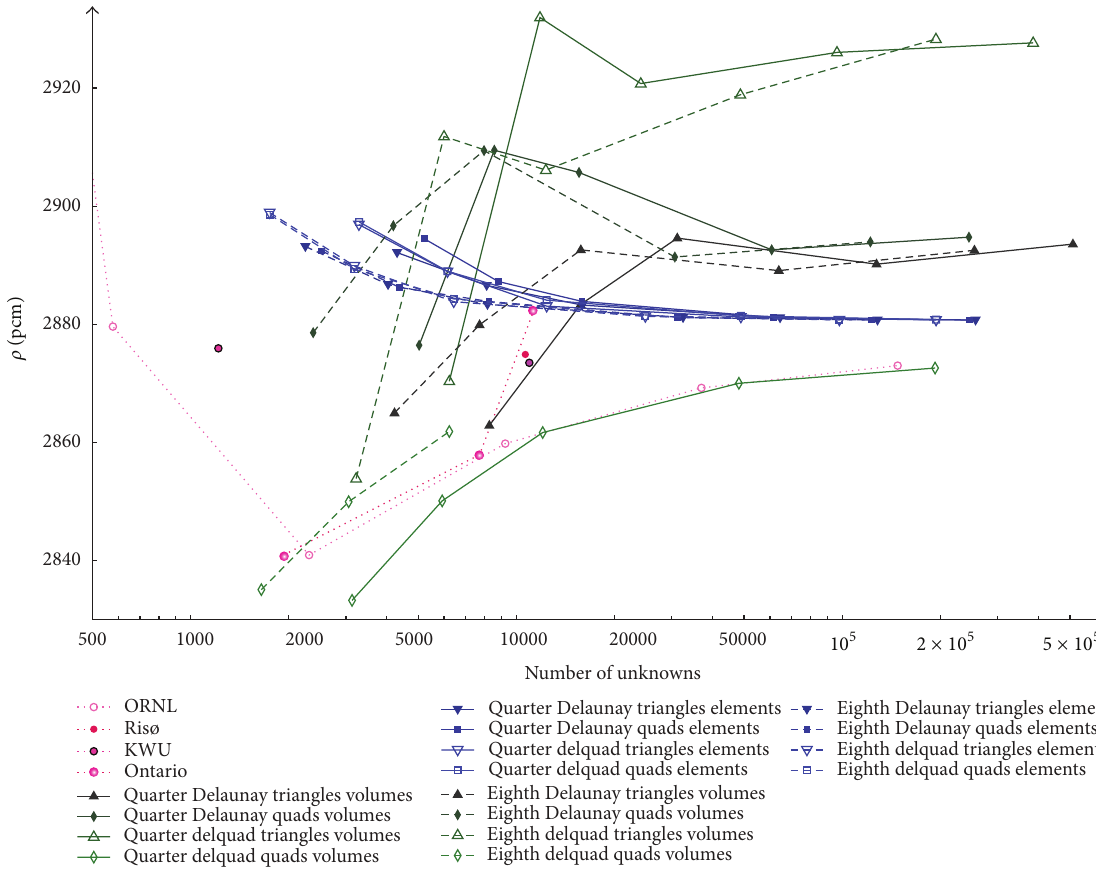
Figure 19: Static reactivity versus number of unknowns. The four original solutions as published in 1977 [10] are included as reference.